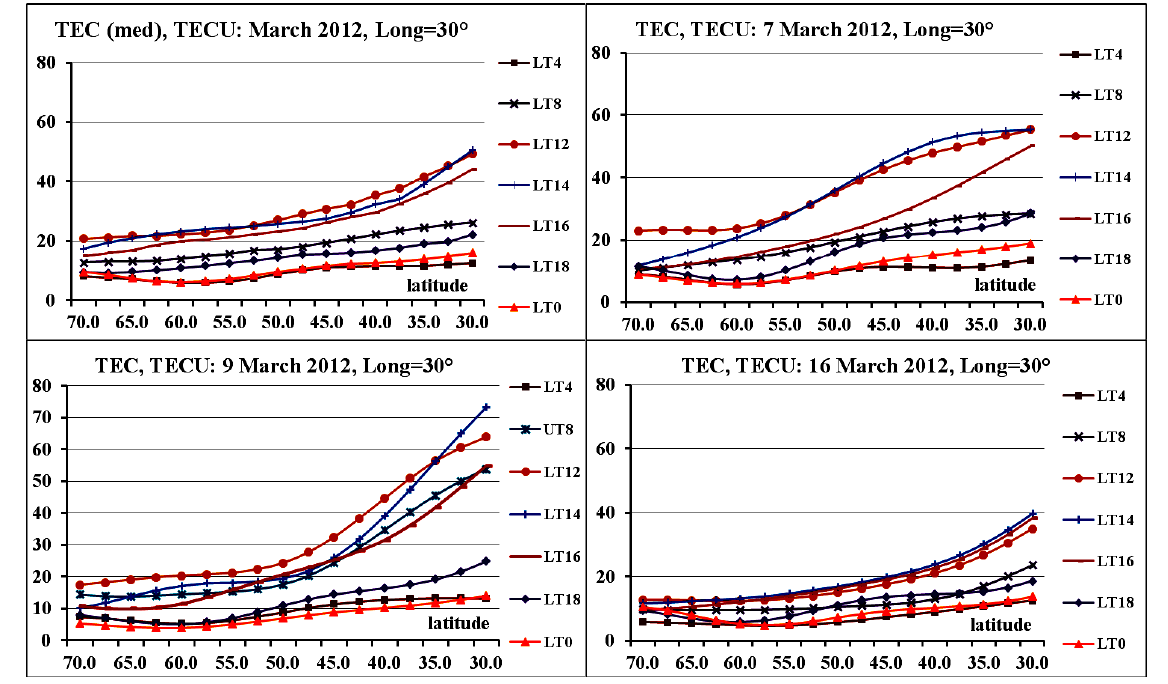
Figure 6. Examples of the ionosphere response to disturbances along the 30° E meridian.